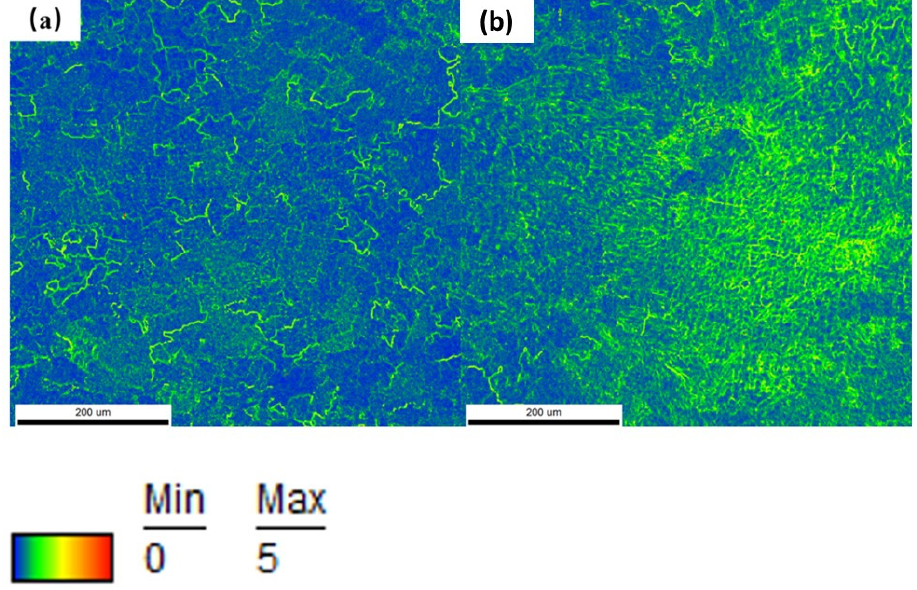
Figure 15. KAM diagram of welds before and after regulation. ( a ) Before regulation; ( b ) After regulation.